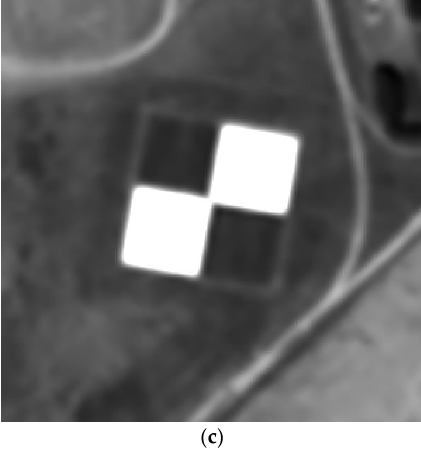
Figure 2. Examples of the spatial characteristics of each band for a target: ( a ) panchromatic image; ( b ) blue band of the multispectral image; ( c ) GF-based image of the blue band.